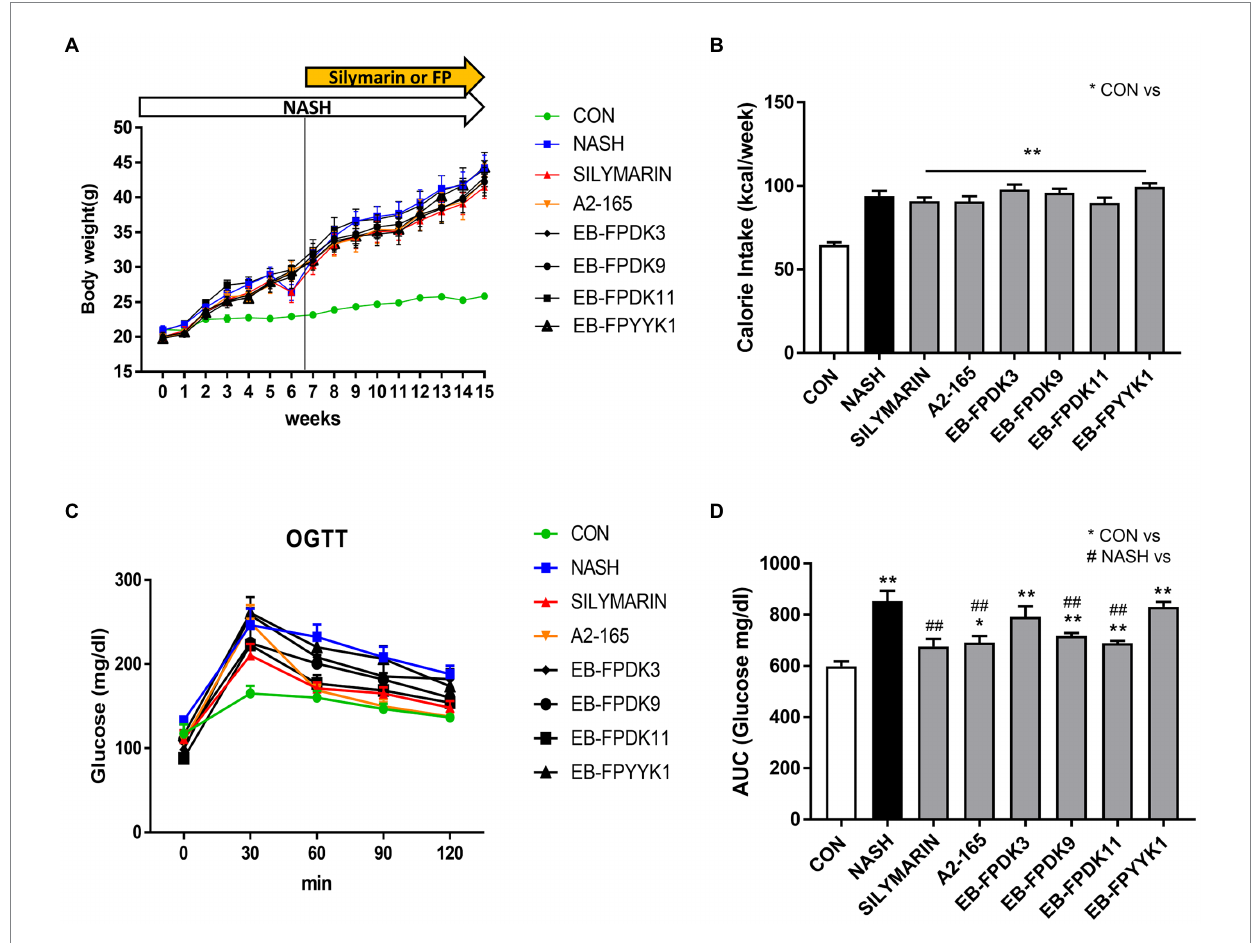
FIGURE 2 Faecalibacterium prausnitzii improves glucose levels in mouse models of NASH induced with a high-fructose and high-fat diet. (A) Body weight changes across 12 weeks. (B) Weekly calorie intake. (C) Oral glucose tolerance test results. (D) Glucose area under the curve with glucose concentration as a function of time. The data are presented as mean ± SEM ( n = 12). Statistical analyzes were performed using Mann–Whitney U test (two tailed) (B,D) . ∗∗ p < 0.01 versus the CON group; ## p < 0.01 versus the NASH group. CON: control, NASH: nonalcoholic